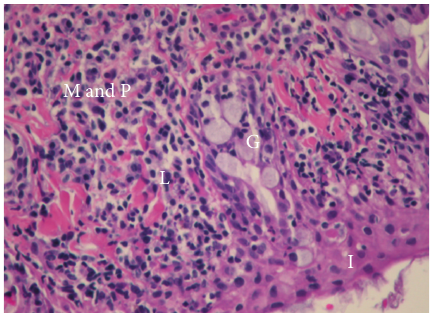
Figure 2: Chronic inflammatory reaction. G: goblet cells, I: infiltra- tion of inflammatory cells to the epithelium, L: lymphocytes, and M & P: mononuclear and polymorphonuclear